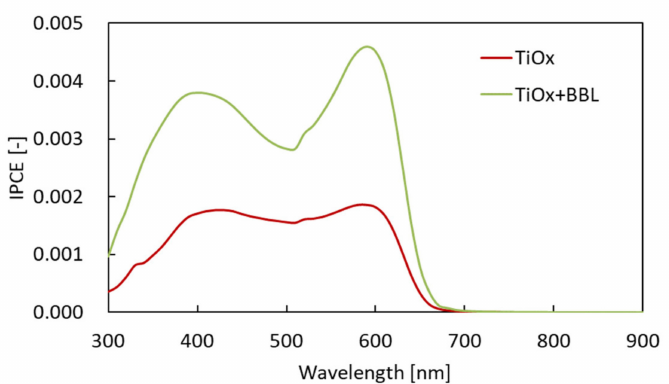
Figure 5. IPCE spectra of each solar cell (red: solar cell with single electron acceptor (TiOx only); green: solar cell with hybrid electron acceptor (TiOx +